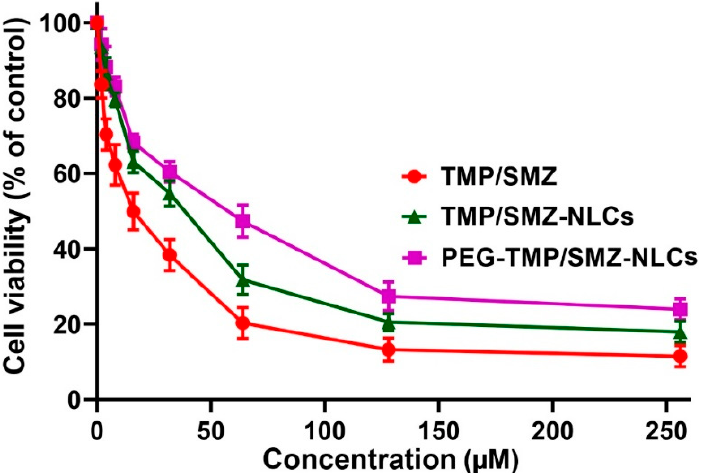
Figure 4. Cell toxicity effects of TMP/SMZ-NLCs and PEG-TMP/SMZ-NLCs, compared to TMP/SMZ, against human embryonic kidney HEK293 cells, measured by MTT assay. The results were expressed as mean ± SD (n = 3).